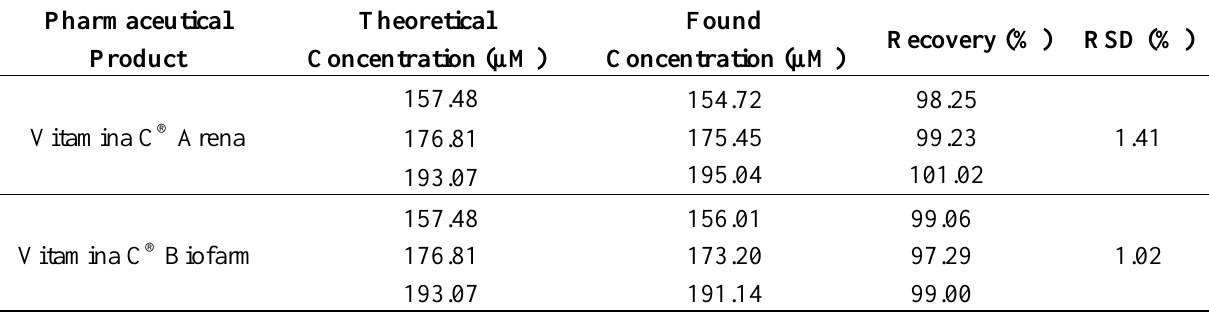
Table 3. Ascorbic acid determination in pharmaceutical products on PEI + β -CD/GCE by using SWV.